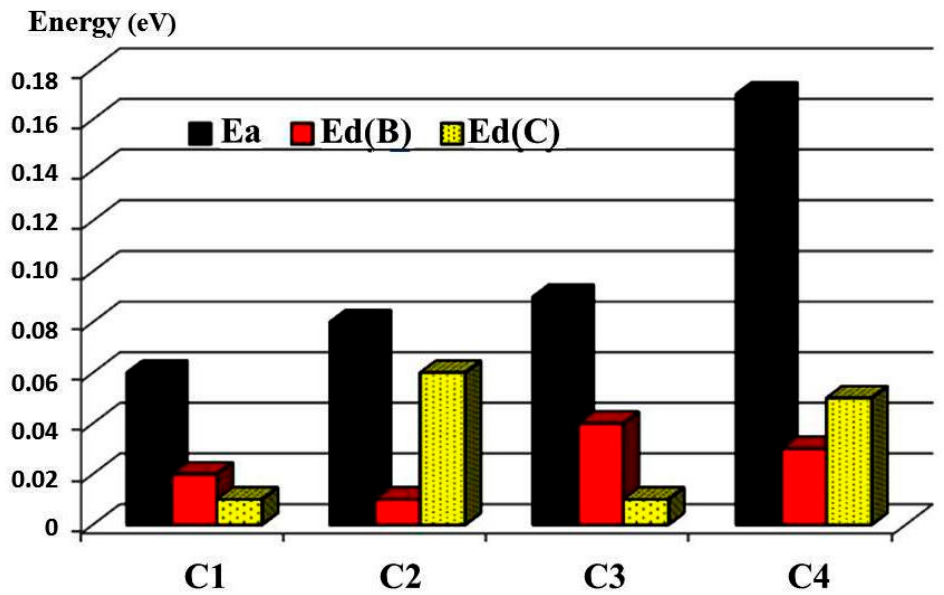
Figure 12. Comparison of absorbed energy (Ea) and the delivered energy (Ed) to the dicarboxybipiridine (B) and chromophoric (C) ligand for the four complexes.